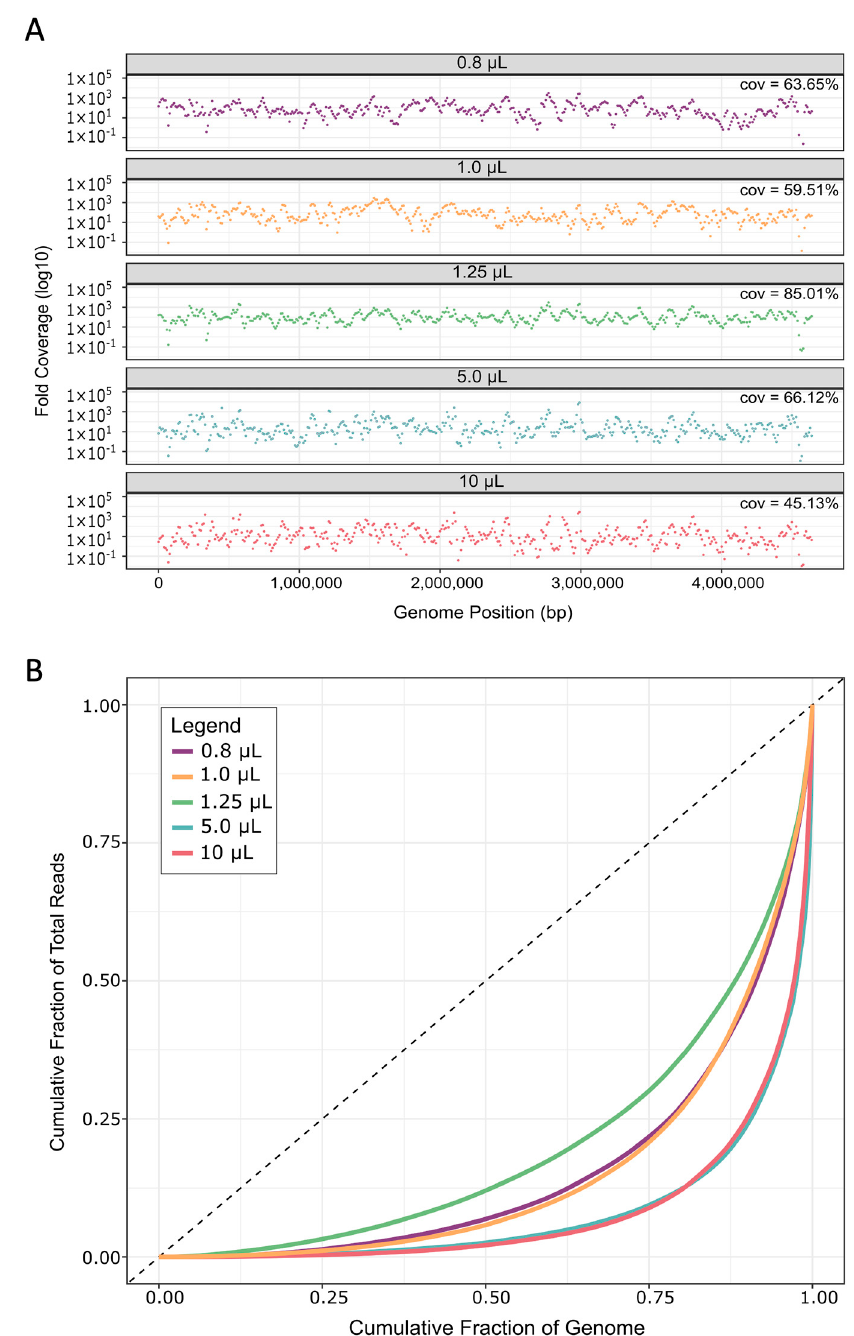
Figure 5. Genome coverage and coverage uniformity bias. ( A ) Read depth from each replicate was calculated in 10 kb bins across the E. coli genome. Plots show the average across all replicates for each reaction volume. Cov. is the average coverage breadth, i.e., the percentage of genome positions covered by at least one read. ( B ) Uniformity of read coverage and depth were calculated across 10 kb bins along the E. coli genome and averaged for all five replicates of each reaction volume.